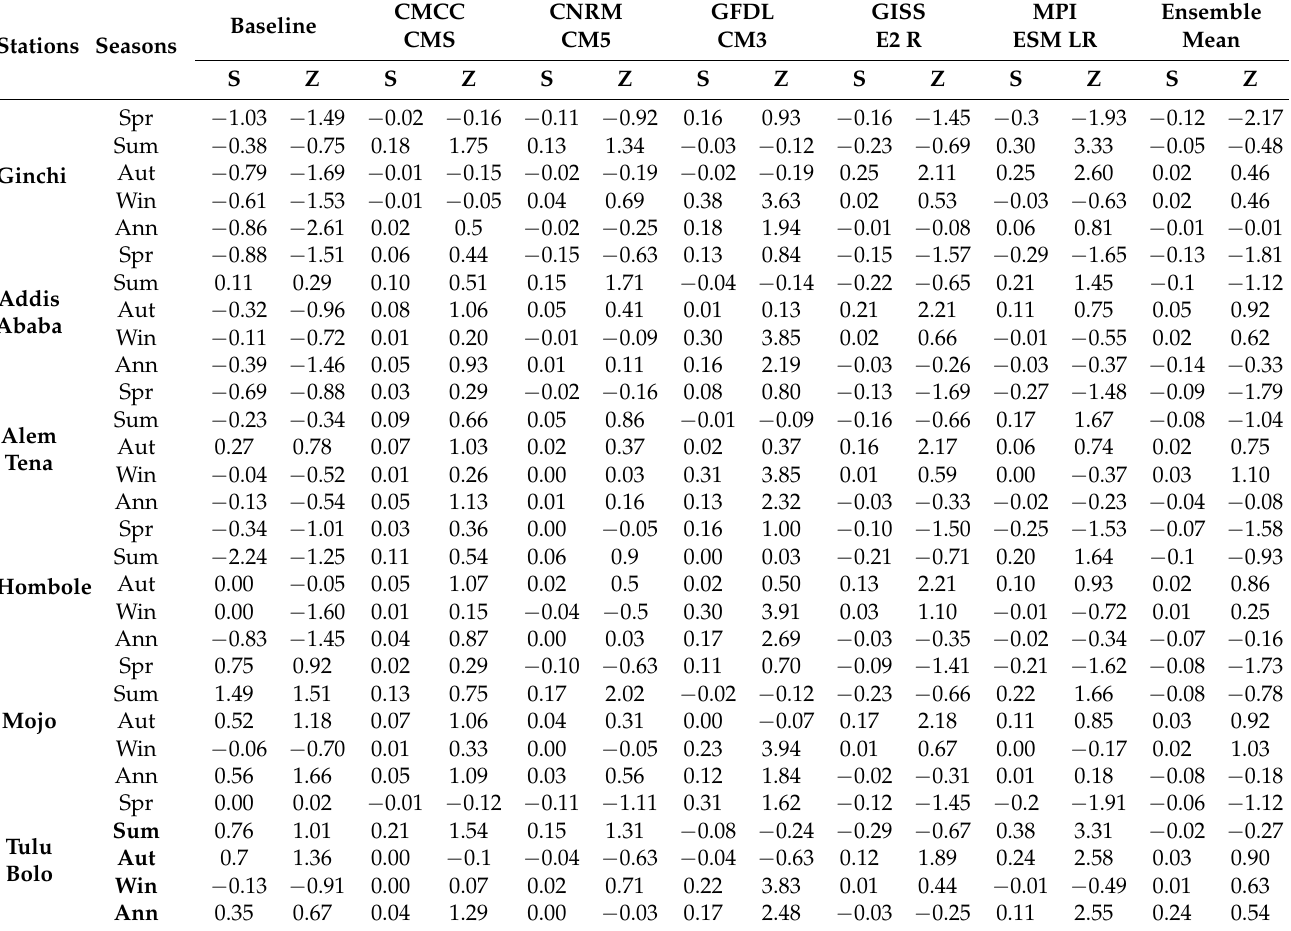
Table 9. Annual and seasonal precipitation trends for the baseline (observed) period and projected future period for different GCMs. Minus sign( − ) indicate a negative trend. S is Sen’s slope (mm) and Z the